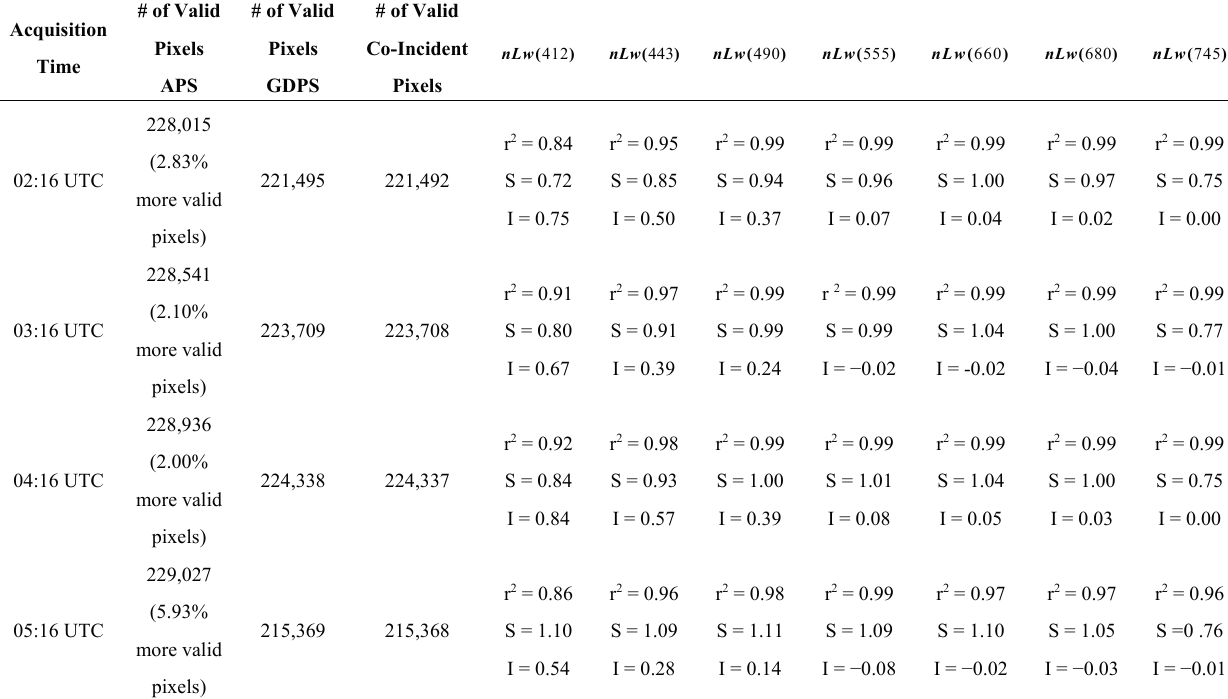
Figure 2. GOCI scene collected at 03:16 UTC on 5 April 2011: ( a ) true color image created using the TOA total radiance ( Lt ); ( b ) true color image created using APS processed (atmospherically corrected) nLw ; and ( c ) true color image created using GDPS processed (atmospherically corrected) nLw . Table 3. Slopes (S), intercepts (I), and coefficient of determination (r 2 ) of regression analyses obtained between APS and GDPS processed nLw . Regression analyses were performed on the 05:16 UTC. Each regression was established for the ROI shown in Figure 2a with the red box containing a total 230,231 pixels (before quality control) for each